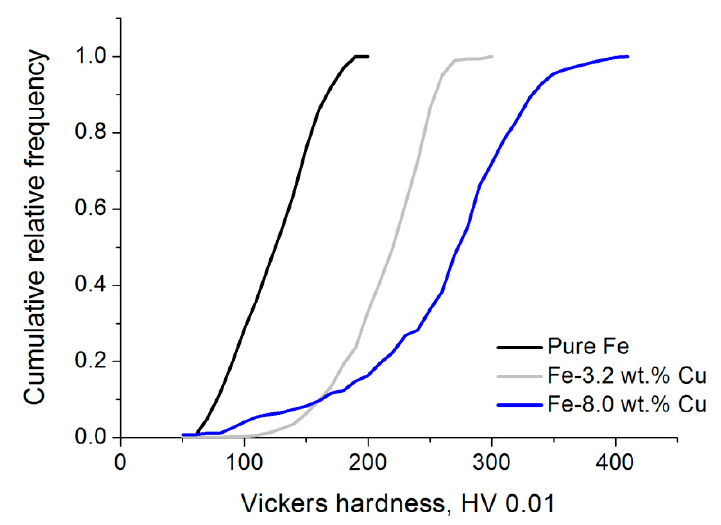
Figure 8. Cumulative relative frequency of occurrence as a function of hardness number.